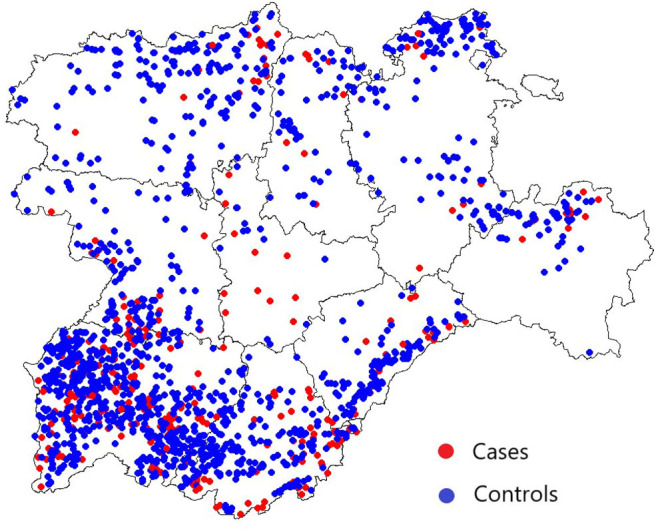
Spatial distribution of case and control herds in Castilla y Leon included in the case-control study. The red and blue circles denote the location of case and control herds, respectively.